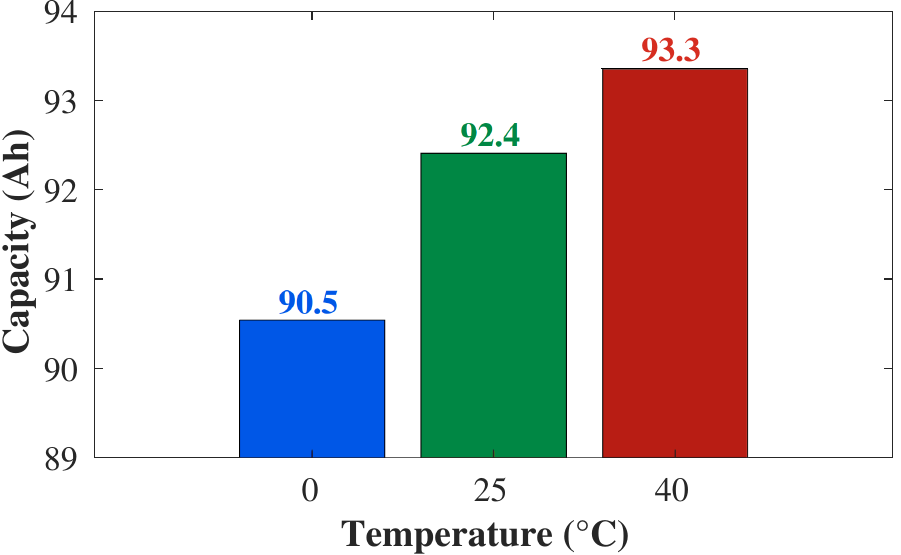
Figure 4. Discharge capacity measured at 0 °C (blue bar), 25 °C (green bar) and 40 °C (red